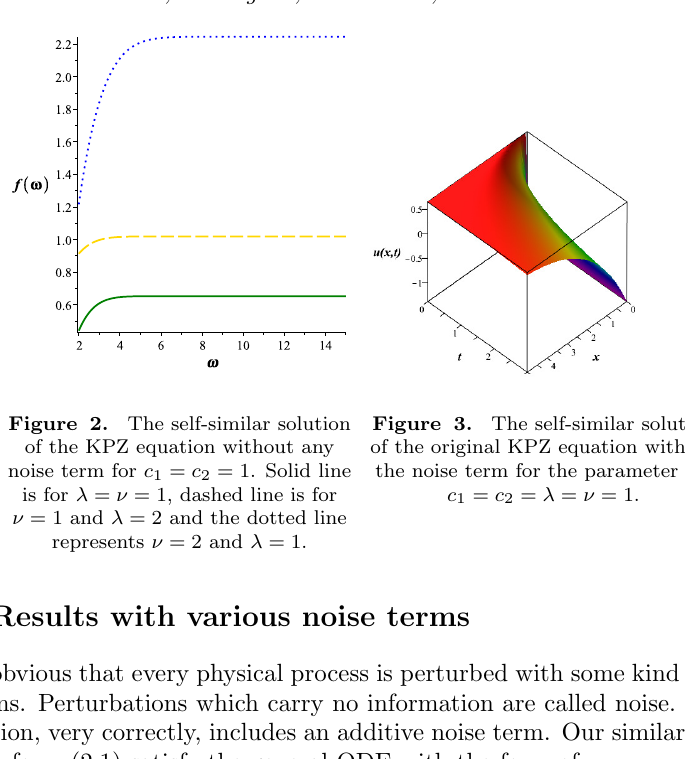
Figure 3. The self-similar solution of the original KPZ equation without the noise term for the parameter set c 1 = c 2 = λ = ν =